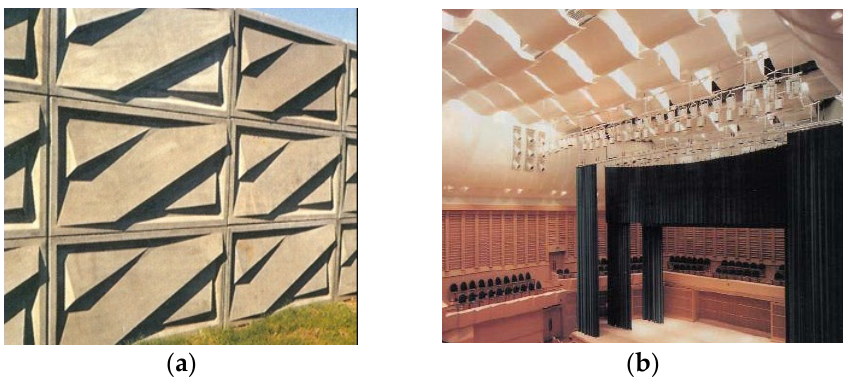
Figure 31. ( a ) GFRC external acoustic screens [129]; ( b ) GFRC internal acoustic panels [130].